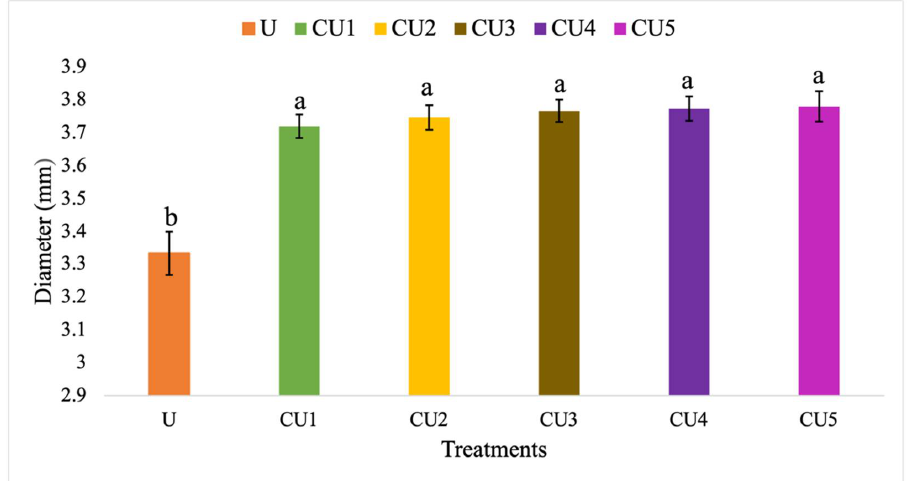
Figure 6. Diameter of the coated and uncoated urea. Mean values with different letter(s) indicate the significant difference between treatments using Duncan’s test at p ≤ 0.05. The error bars show the standard errors on the replicates in the means of each